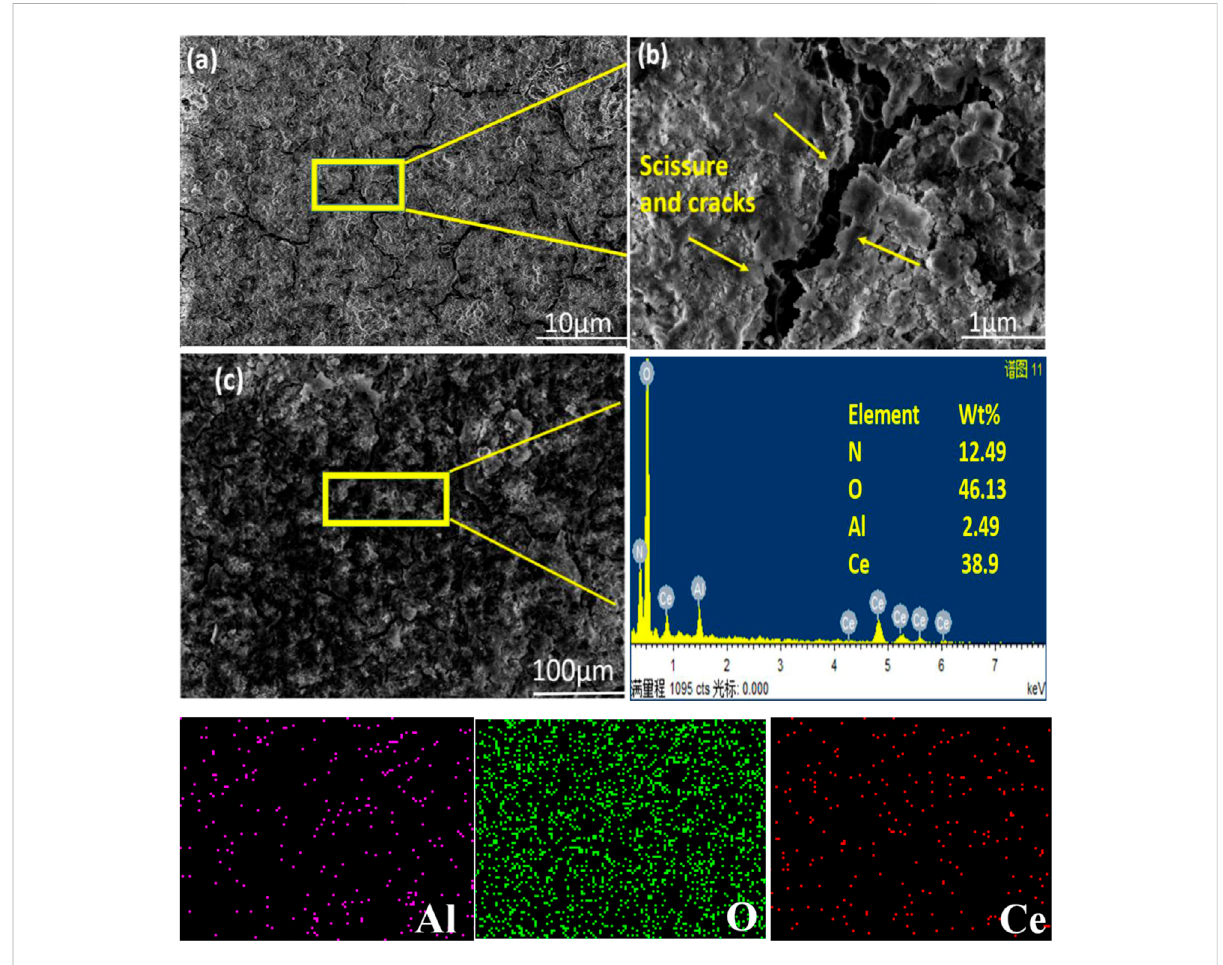
FIGURE 4 SEM images of the coating after 21 days of immersion in an alkaline NaOH solution. (A) showing cracks, (B) magni fi ed mage, and (C) EDS of the elemental